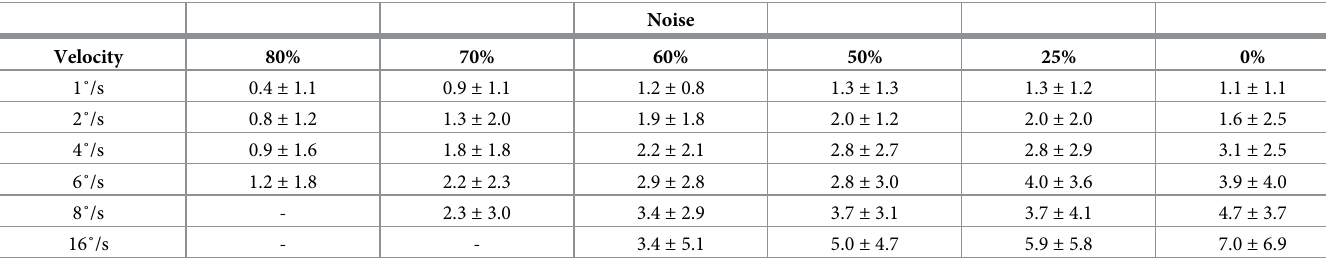
Table 1. Grand mean bar angle for each condition and their standard deviations (n = 10) derived from the shaded region in Fig